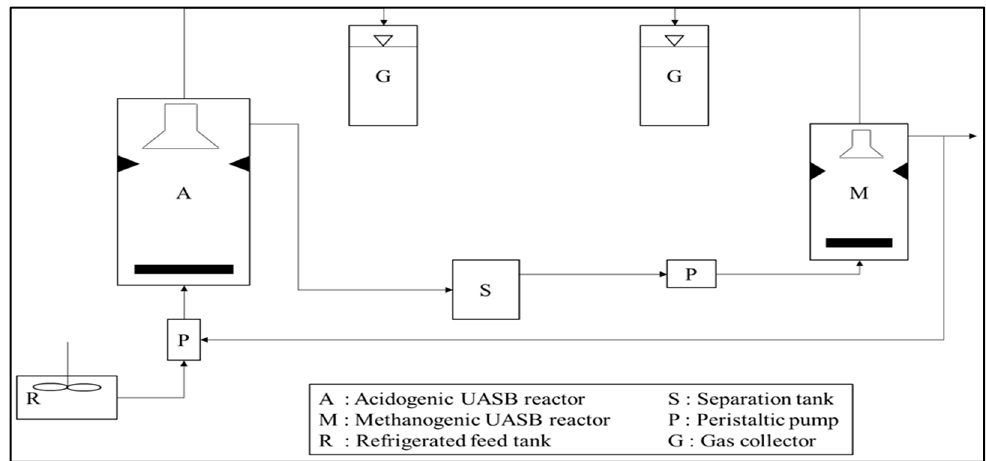
Figure 5. Schematic diagram of the two-stage UASB system. Adapted with permission from ref. [51]. Copyright 1996 Elsevier.